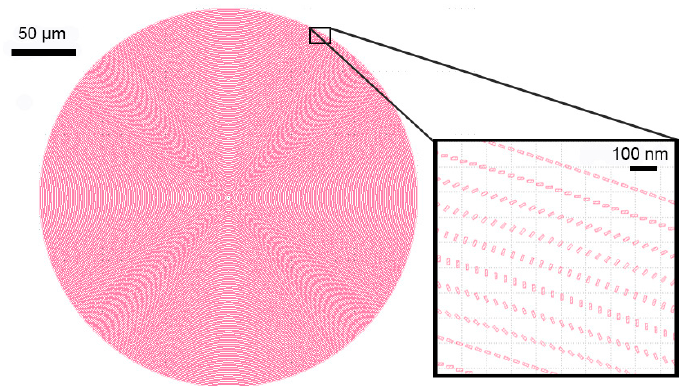
Figure 1. Simulated pattern of 800 µm focal length metalens with a closer view of nanoantenna alignment at the edge of the lens.